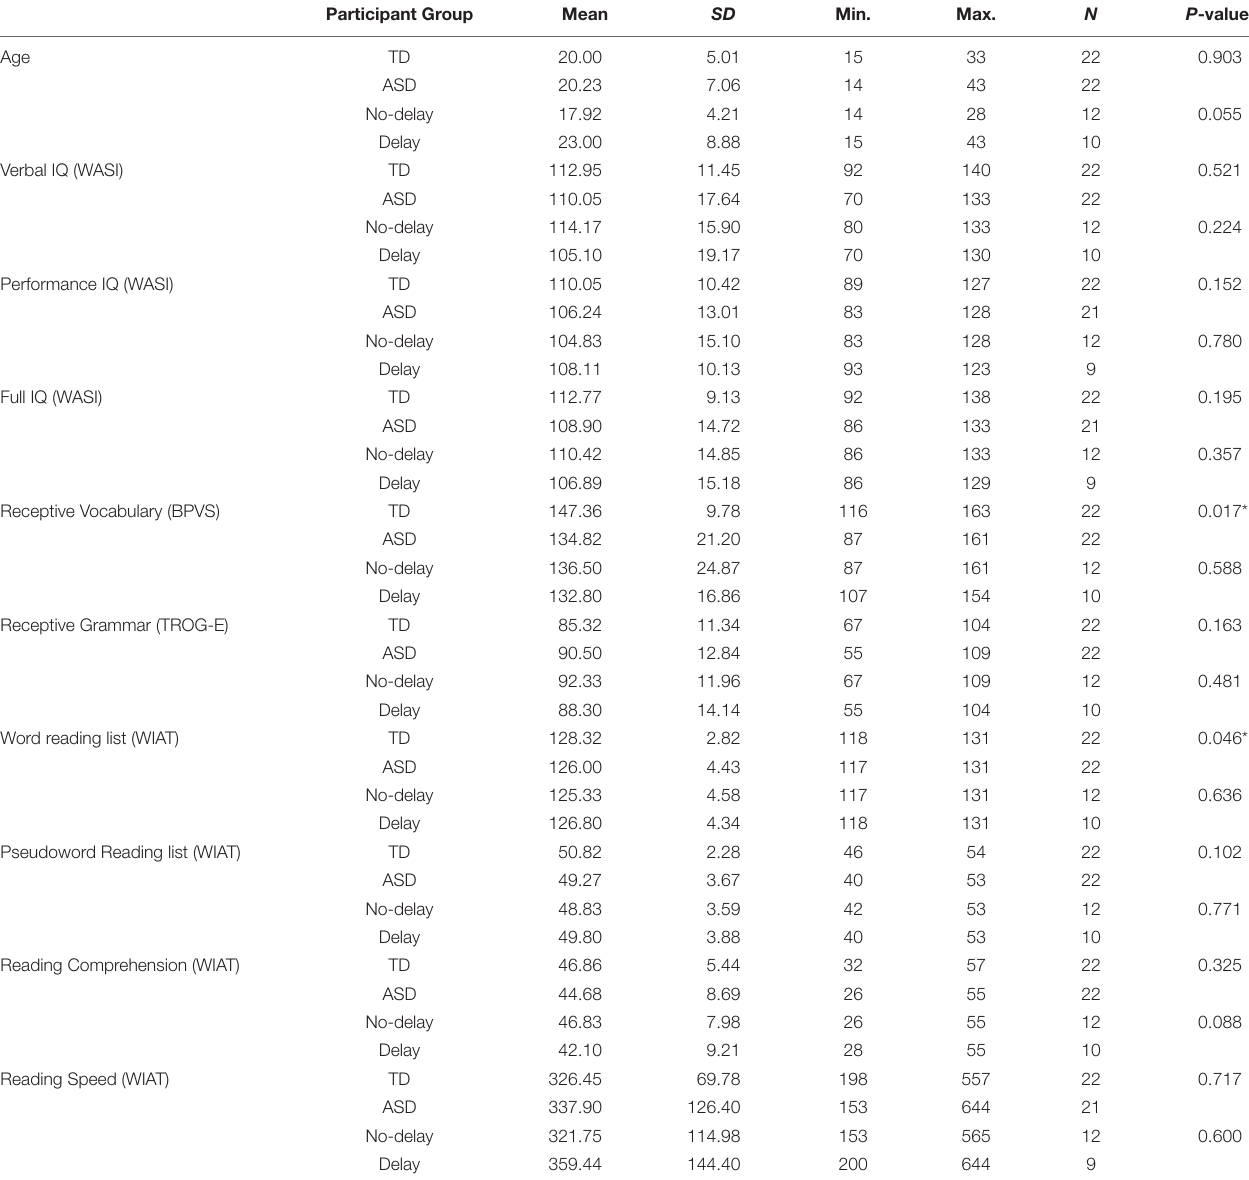
TABLE 1 | Pre-assessment results for individuals who participated in the study. Participant